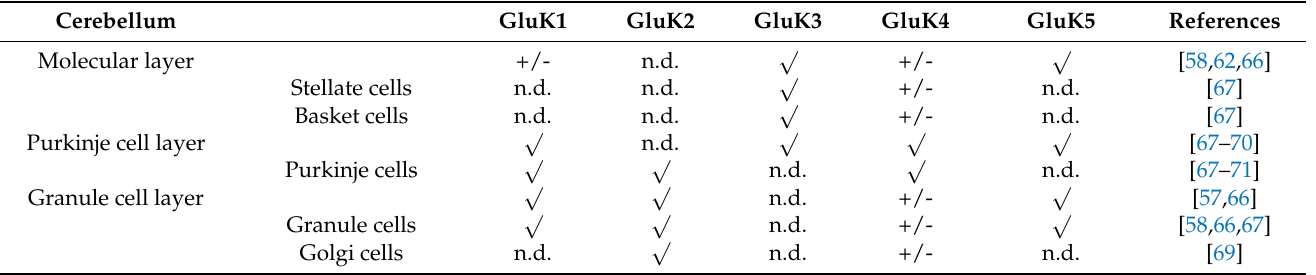
Table 2. Transcripts of KAR subunits in the